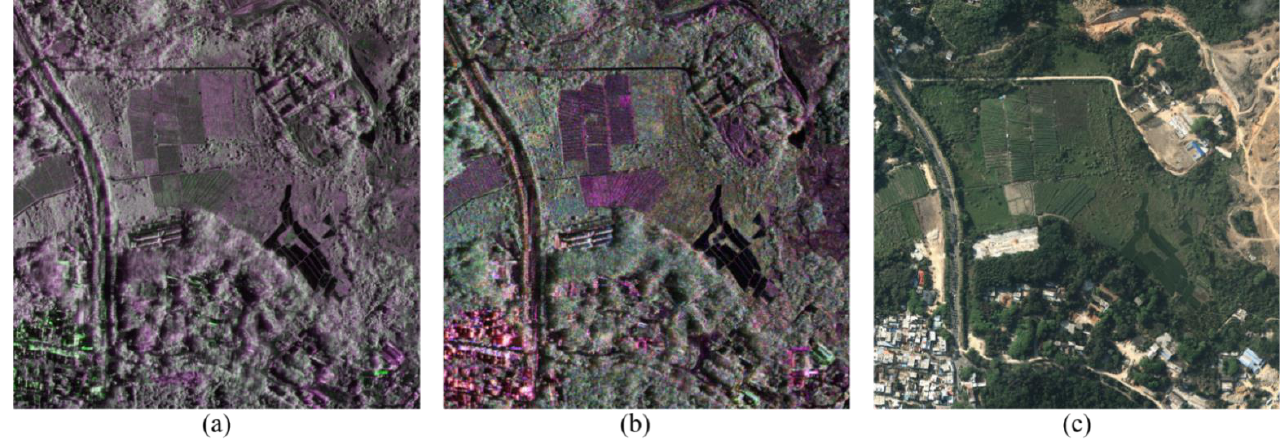
Figure 3. Scene 1. ( a ) Ka-band multi-polarization SAR image. ( b ) S-band multi-polarization SAR image. ( c ) Optical image.